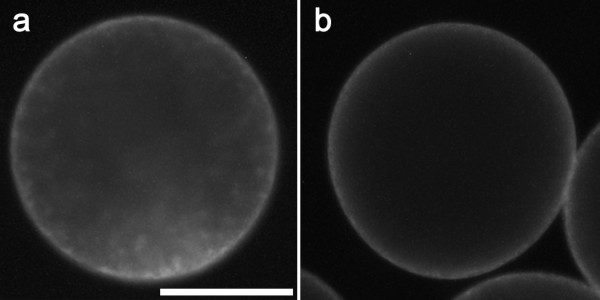
Endocytosis is inhibited by actin disruption. Zygotes 6 h AF were treated for 30 min with DMSO (a) or 30 nM Lat B (b) and then labeled with FM4-64 for 30 min in the presence of drug. Diffuse cortical fluorescence in (b) is primarily due to out-of-focus labeling of plasma membrane. Bar = 50 μm.